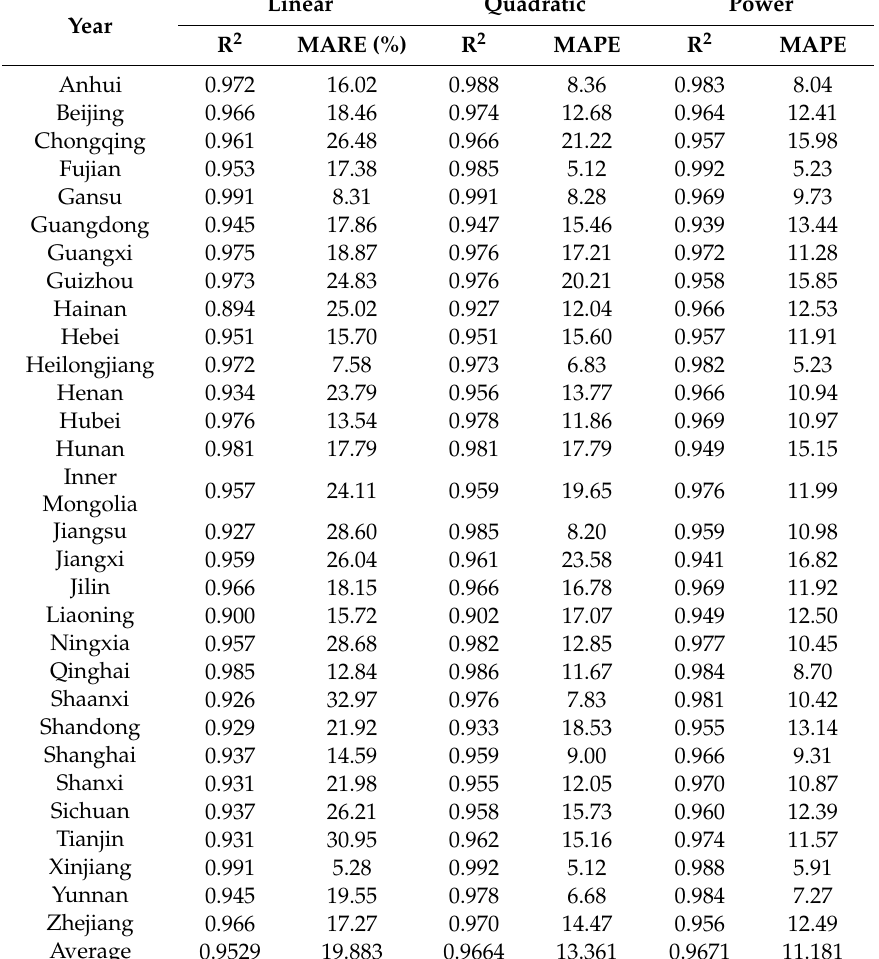
Table 9. Model fitting precision values between TNL and GDP in time series.